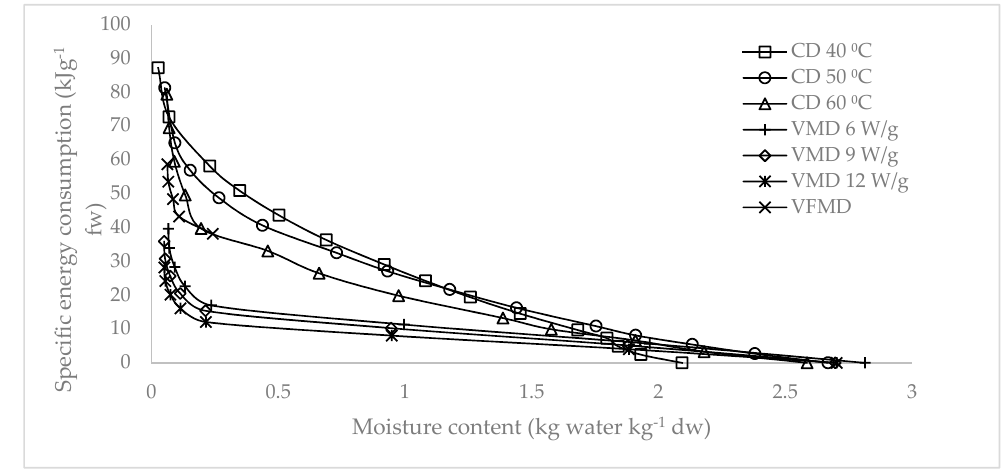
Figure 7. Specific energy consumption of S. crispus leaves per gram of fresh weight dried using CD, VMD, and CPD-VMFD.